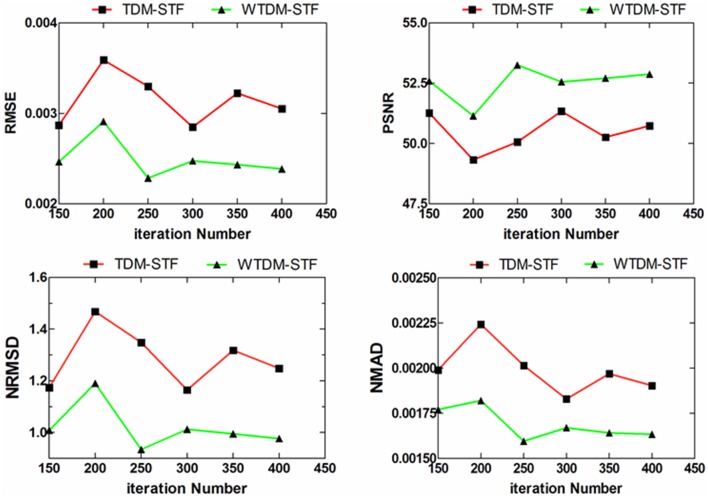
Different performance evaluations as a function of iteration numbers on the reconstructions by TDM-STF and WTDM-STF from noisy projection data.